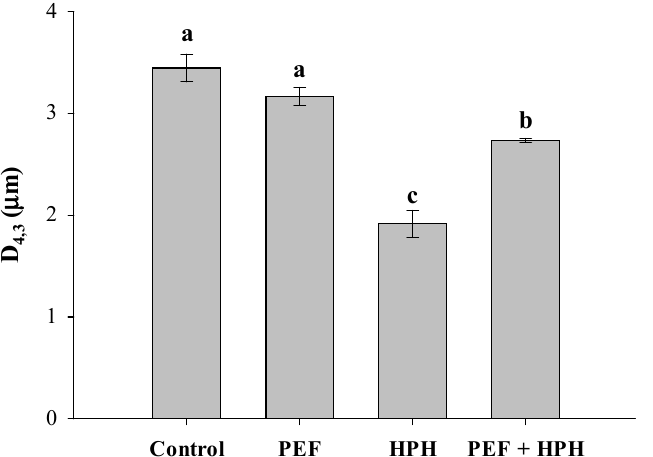
Figure 2. Volume-weighted mean diameter (D 4,3 ) of C. vulgaris suspensions untreated (control) and treated by PEF alone, HPH alone, and combined PEF + HPH. Different letters above the bars indicate statistically significant differences among the samples ( p ≤ 0.05).